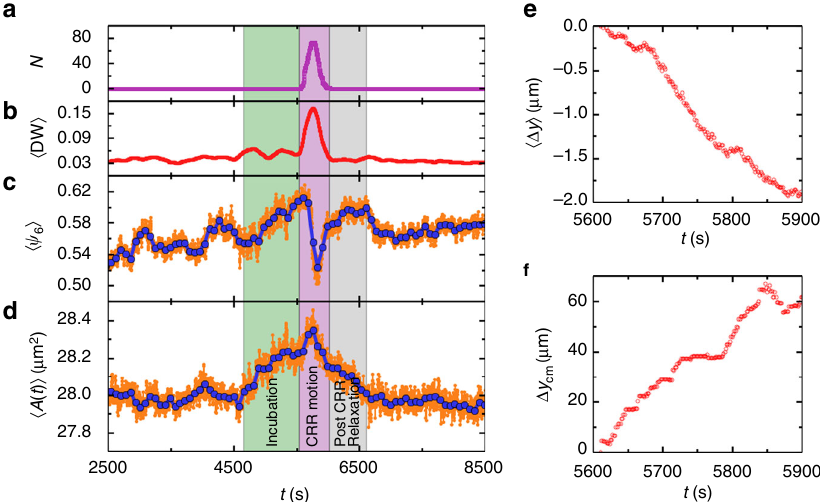
Fig. 4 Evolution of the CRR in Fig. 2a. a Particle number N , b DW factor, c orientational order parameter 〈 ψ 6 〉 , and d Voronoi cell area 〈 A 〉 . 〈〉 represents the average over all 80 particles that have ever participated in the CRR. The blue curves in c , d are smoothed over 50 bins (i.e., 78 s) of the raw data ( orange curve ). e Average displacement 〈 Δ y 〉 of the CRR particles as a function of t . Δ y is the displacement relative to the position at 5610 s. f Displacement of the center of mass Δ y cm of the CRR relative to the position at t = 5610